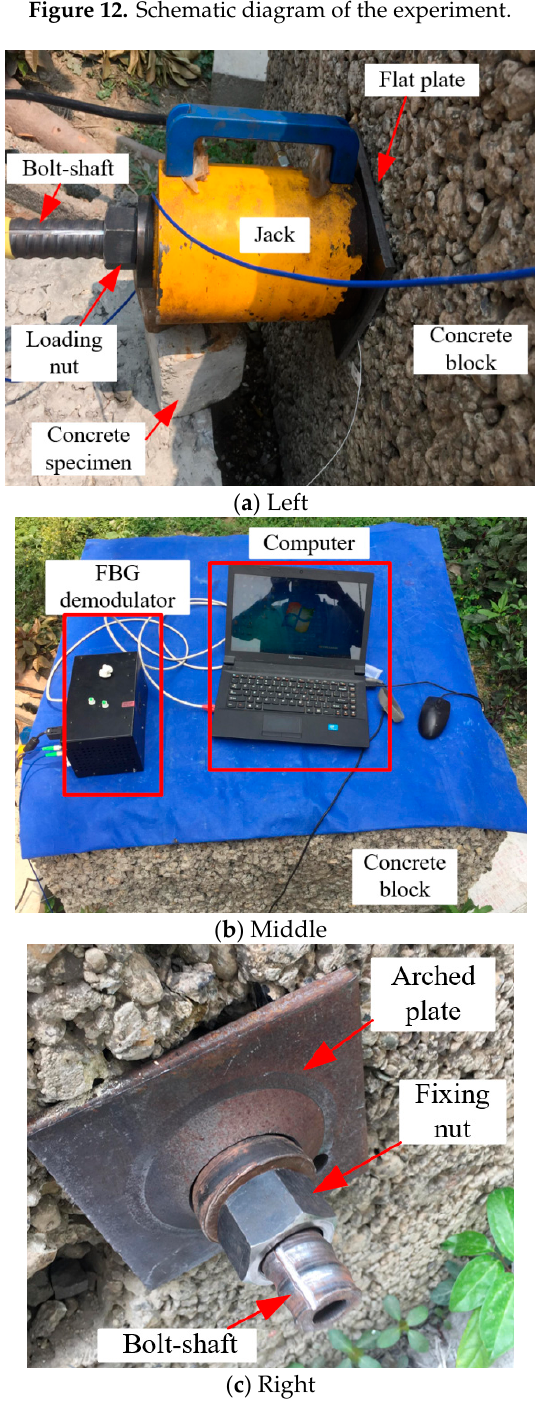
Figure 13. Onsite testing.